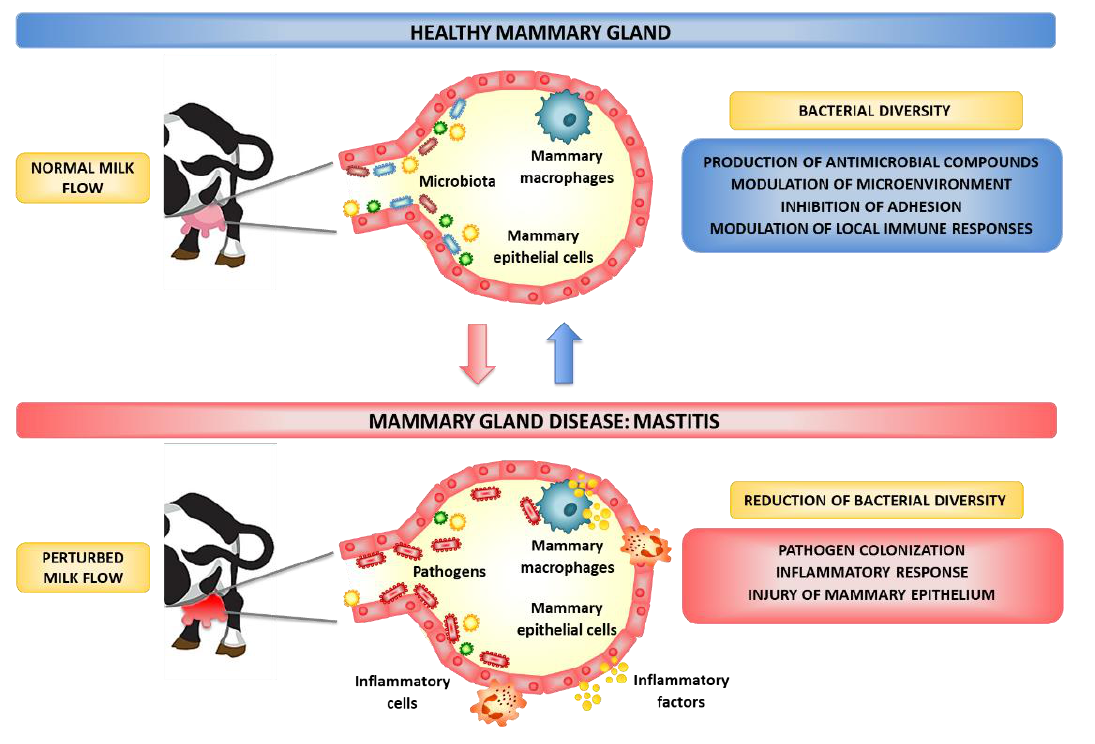
Figure 1. Effect of bovine mammary gland microbiota on the susceptibility to infections.